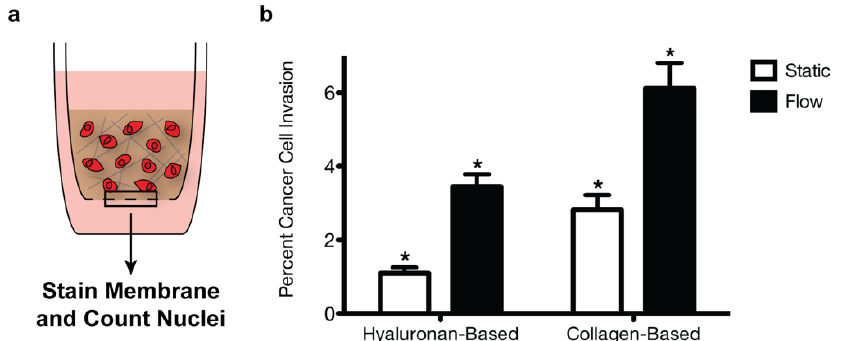
Figure 5. Extracellular matrix composition and fluid flow affect breast cancer cell invasion. MDA-MB-231 breast cancer cells were seeded into collagen-based or hyaluronan-based gels within tissue-culture inserts ( a ). After 18 h, percent invasion was calculated by dividing the number of cells in the insert membrane by the number of seeded cells ( b ). A two-way ANOVA and Bonferroni comparison test were performed to determine statistical significance (* p < 0.05). Error bars represent standard deviation ( n = 3).